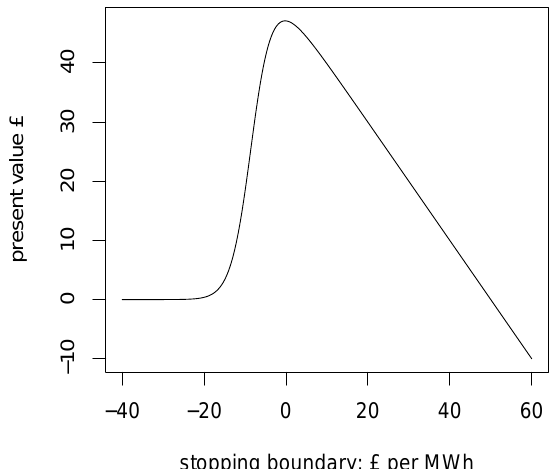
Figure 2. Sensitivity of the expected value in the single problem with respect to the stopping boundary. The EIM price is modelled as an Ornstein-Uhlenbeck process dX t = 3.42 ( 47.66 − X t ) dt + 30.65 dW t (time measured in days, fitted to Elexon Balancing Mechanism price half-hourly data from July 2011 to March 2014). The interest rate r = 0.03, power delivery level x ∗ = 60, the initial premium p c = 10, and the utilisation payment K c = 40. The initial price is X 0 is set equal to x ∗